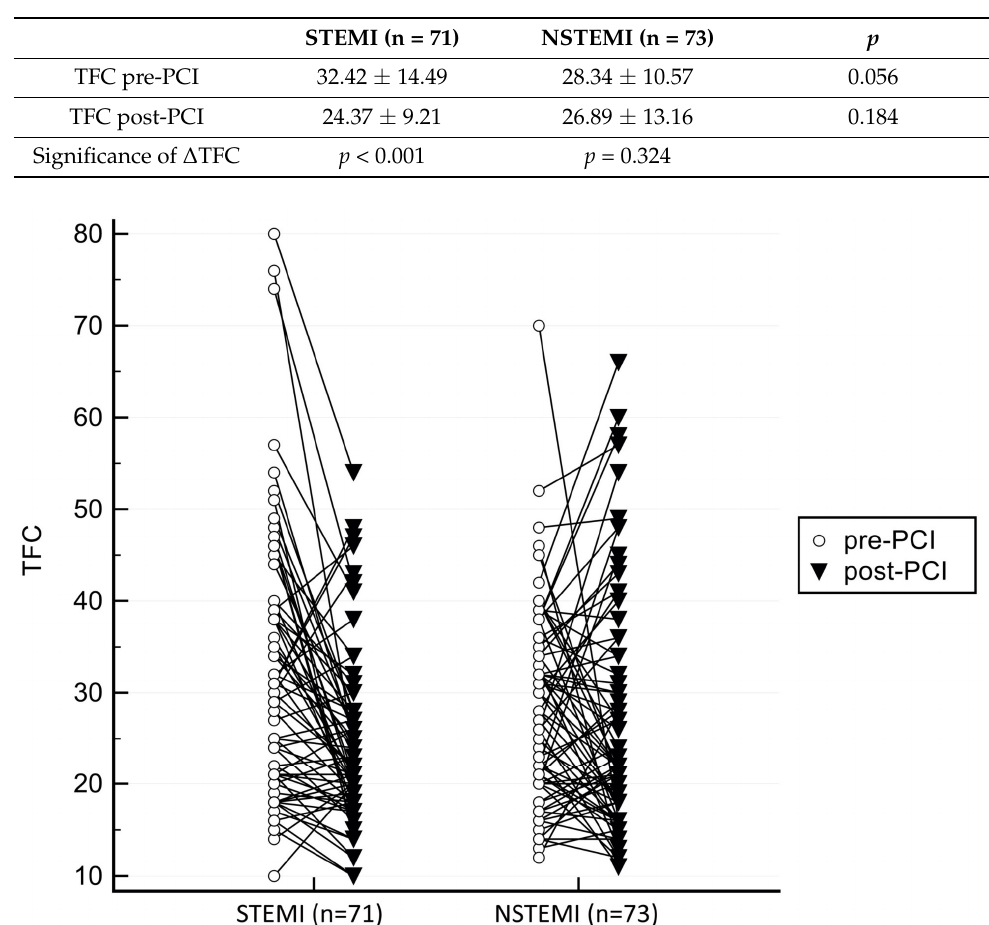
Figure 2. Intragroup pre- and post-PCI TFCs, both in STEMI and NSTEMI, earlier group showing significant changes.